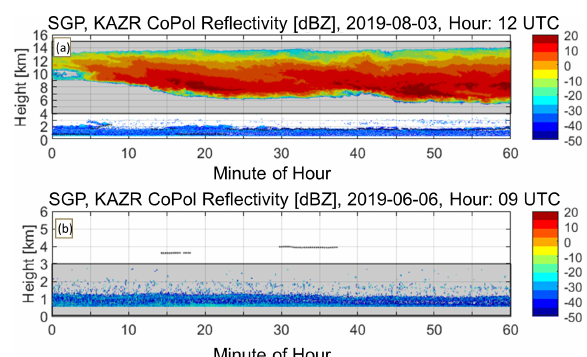
Figure A1. Examples of manual hydrometeor and insect classifi- cation superimposed on KAZR CoPol reflectivity at SGP. (a) The gray bounding box between 4 and 15km contains manually iden- tified hydrometeor scattering observations for hour 12:00UTC on 3 August 2019. (b) The gray bounding box from the lowest range gate to 3km contains manually identified insect scattering observa- tions for hour 09:00UTC on 6 June